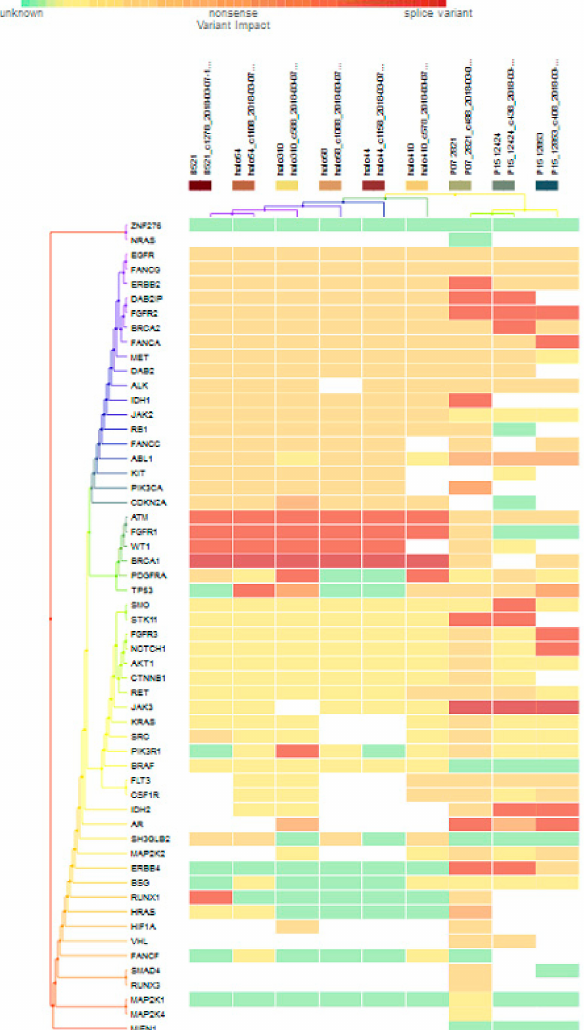
Figure 6. Heat map for 9 HR-/HER2- subtype breast cancer. The variants impacted in 9